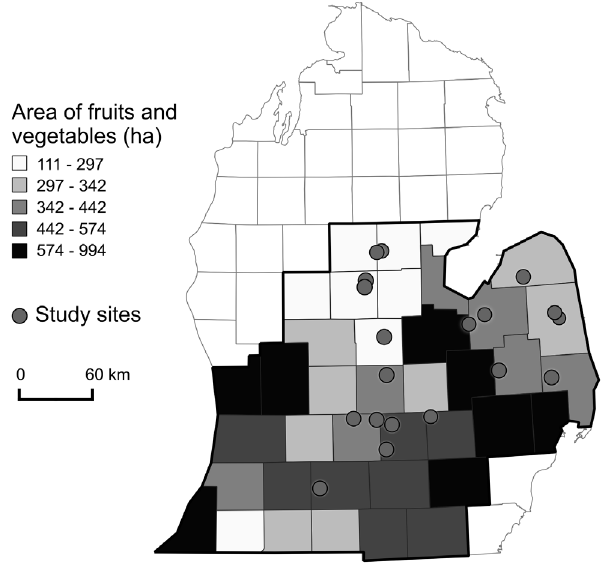
Figure 1. Study sites. Location of study sites sampled for bees across Michigan. Hectares of fruits and vegetables are calculated on a county basis and shown for the lower region of Michigan.